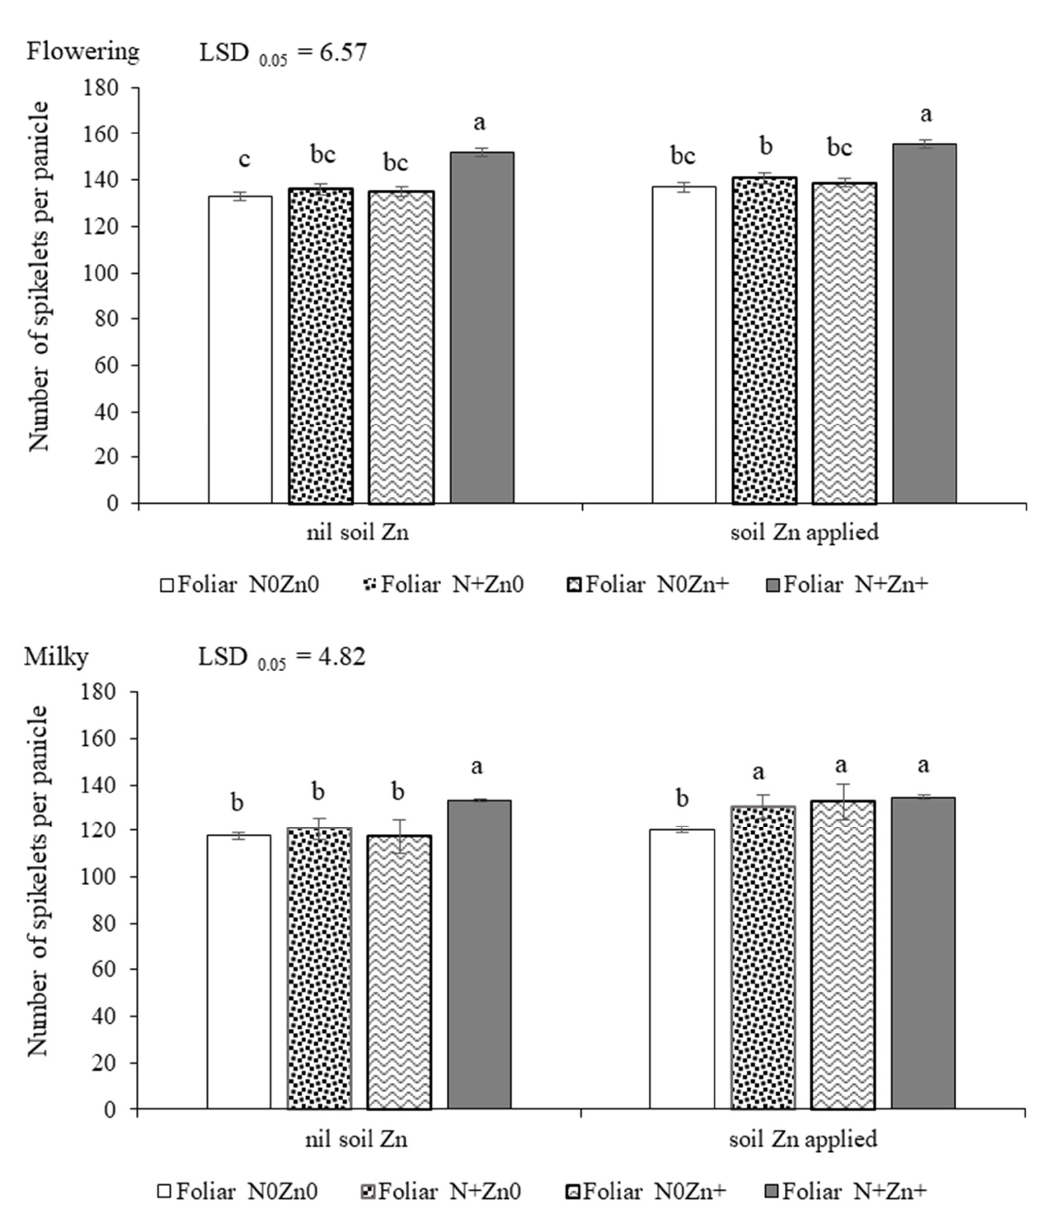
Figure 5. Number of spikelets per panicle of the SPT1 rice variety grown at different foliar N and Zn fertilizer rates under two soil Zn treatments at the flowering and milky stages. Each value is the mean of four independent replications. Different letters above the bars indicate a significant difference by LSD (0.05). The error bars indicate the standard deviation of each treatment mean (SD) ( n = 4).